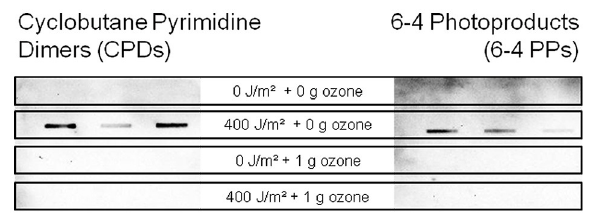
immunological slot-blot